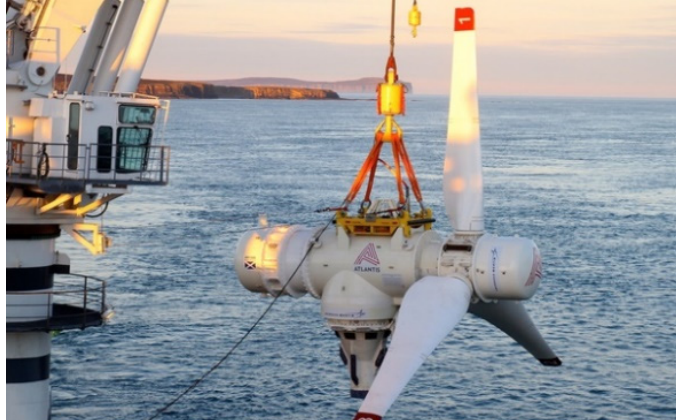
Figure 1. AR2000 tidal turbine [6]. Table 1. AR200Horizontal Axis Tidal turbine parameters [7].